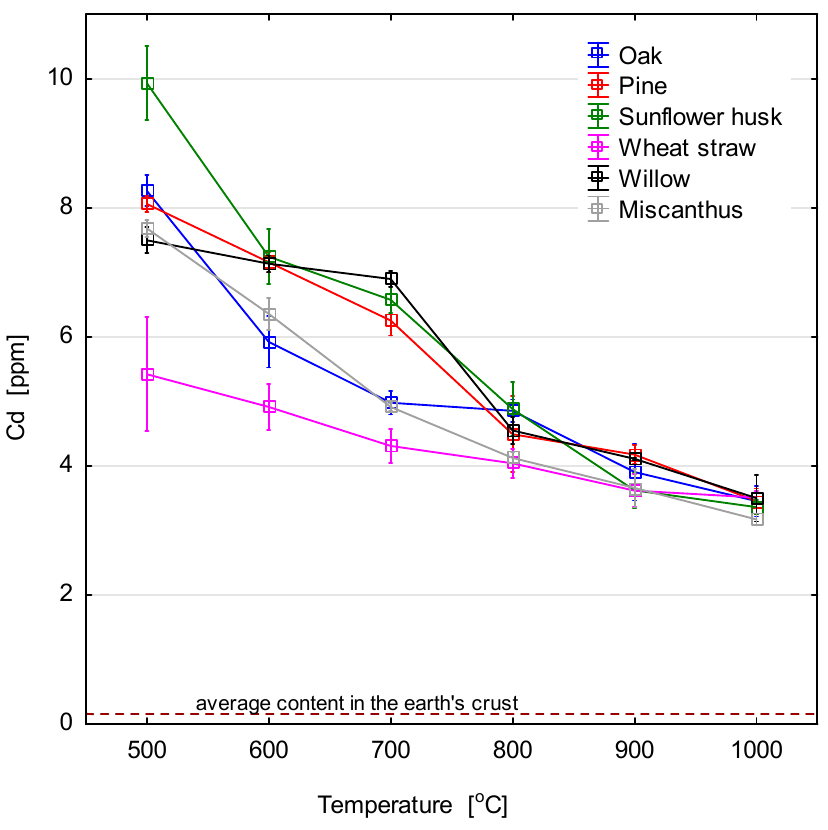
Figure 4. Changes in Cd content in the examined biomass depending on ash-forming temperature.